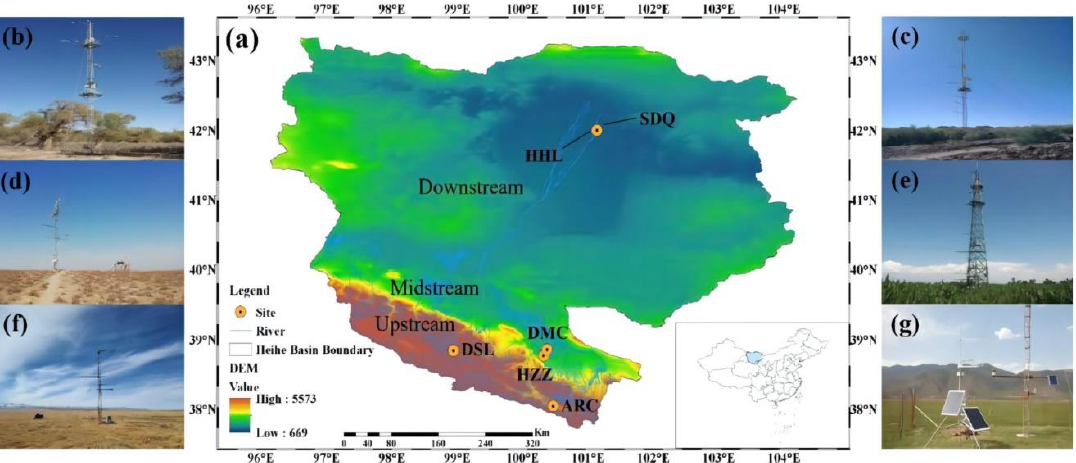
Figure 1. The location of observation sites and landscape of each site on the HRB. ( a ) The location of six observation sites; ( b ) P.euphratica at the HHL site; ( c ) T.ramosissima at the SDQ site; ( d ) Kalidium foliatum at the HZZ site; ( e ) Cropland at the DMC site; ( f ) Apline swamp meadow at the DSL site; ( g ) Apline meadow at the ARC site. Table 1. Main characteristics of the typical ecosystems in the study